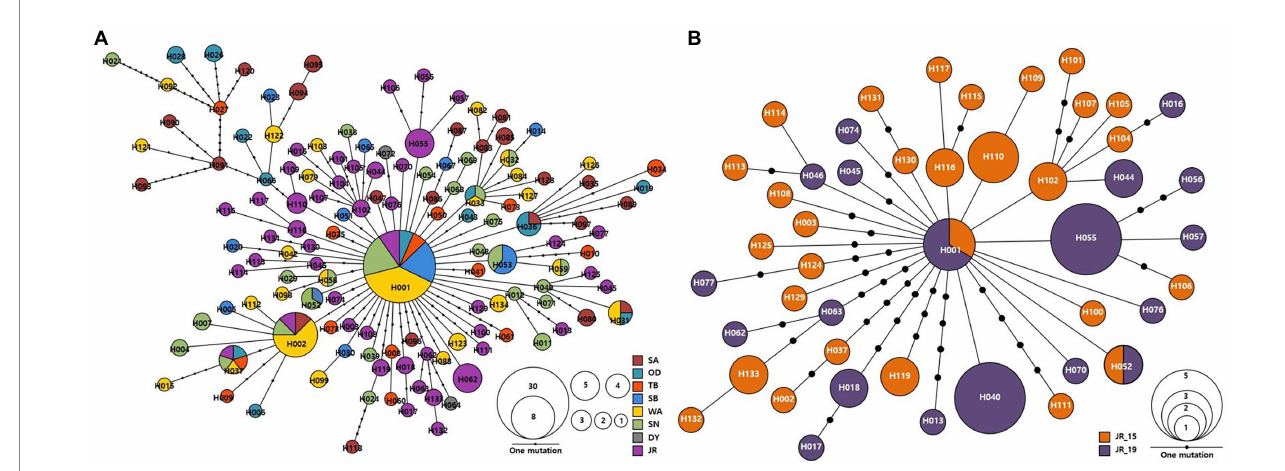
FIGURE 2 Haplotype network of the observed 134 haplotypes in Apodemus agrarius from entire pooled population (A) and 46 haplotypes from the Jirisan National Park population (JR_15 and JR_19) (B) , based on mtDNA cyt b sequences (802 bp). Each line in the network represents a single mutational step between haplotypes, irrespective of its length. The size of the circle is proportional to individual numbers that belong to the respective haplotypes and small, filled circles denote intermediate haplotypes that are not present in our samples, but are necessary to connect all of the observed haplotypes to the network. Different colors indicate different national park populations. Population abbreviations as Table 1.